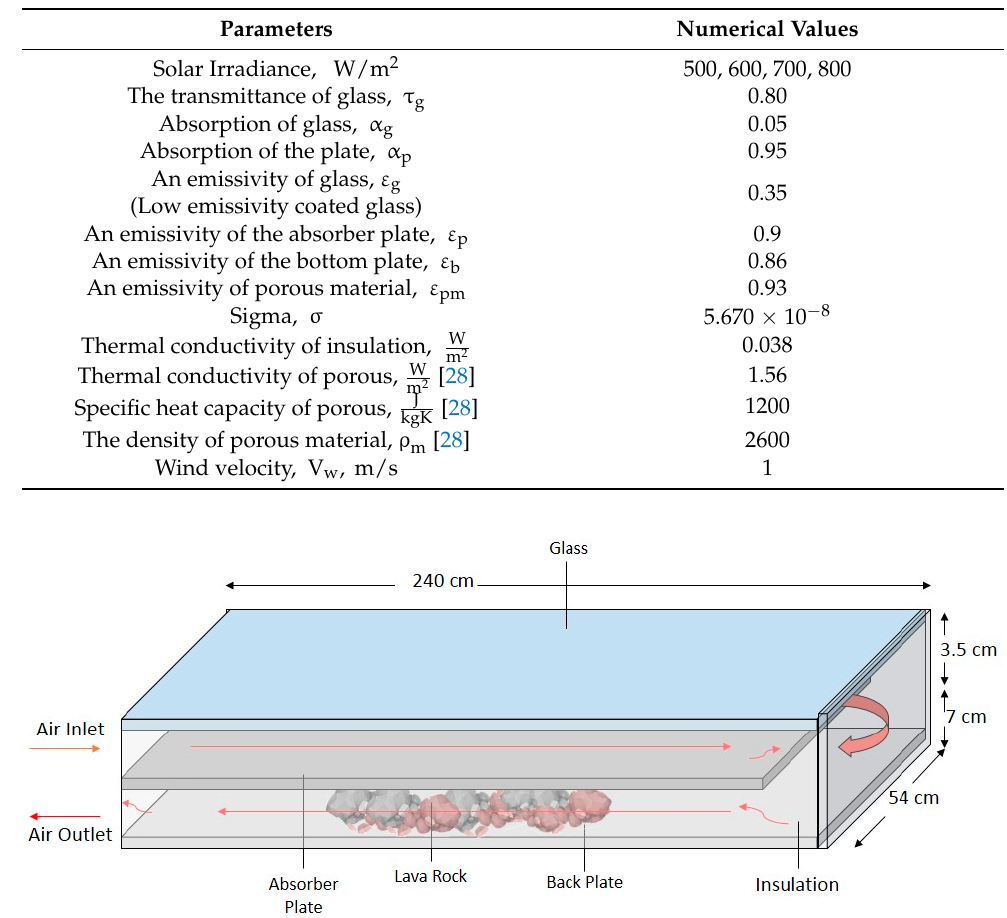
Figure 3. ( a ) Images of lava rock (Scoria type) ready for installation, ( b – d ) Scanning Electron Dif- fraction (SED) images of the lava rock (Scoria type) under different magnification showing the po- rosity of the rock.